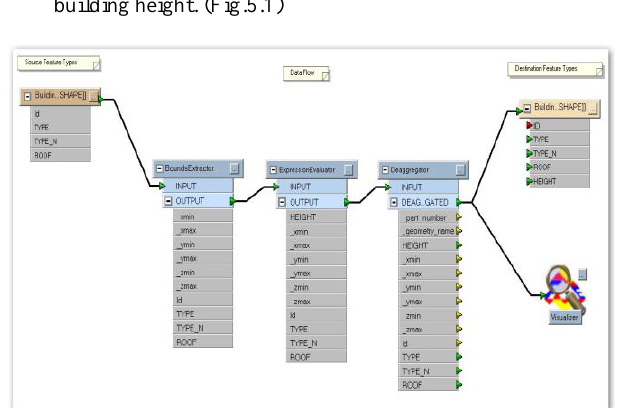
Figure 5.1: Conversion from ESRI Multipatch to ESRI PolygonZ shape